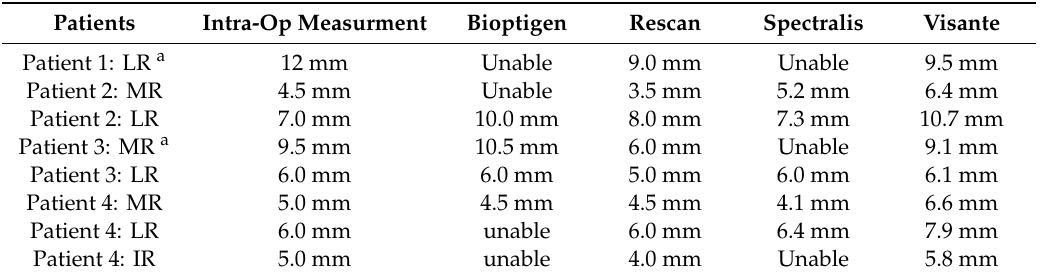
Table 2. Patients able to be imaged with all four optical coherence tomography machines.